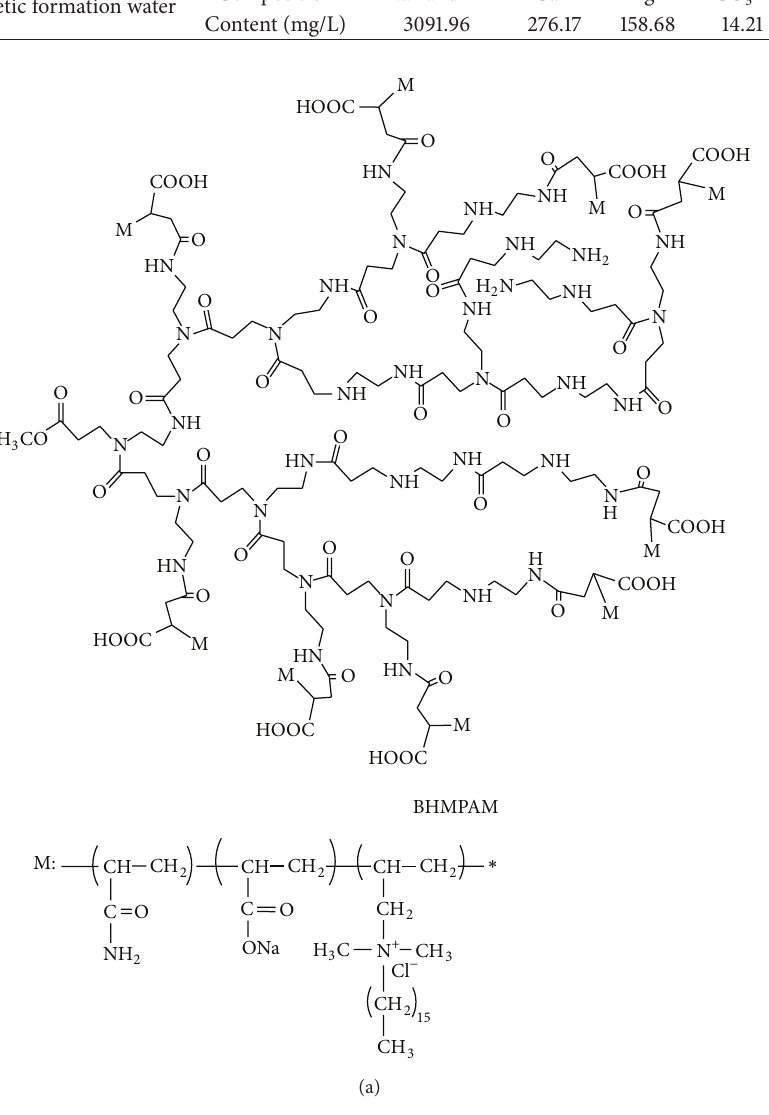
Figure 1: The structure of BHMPAM compared to